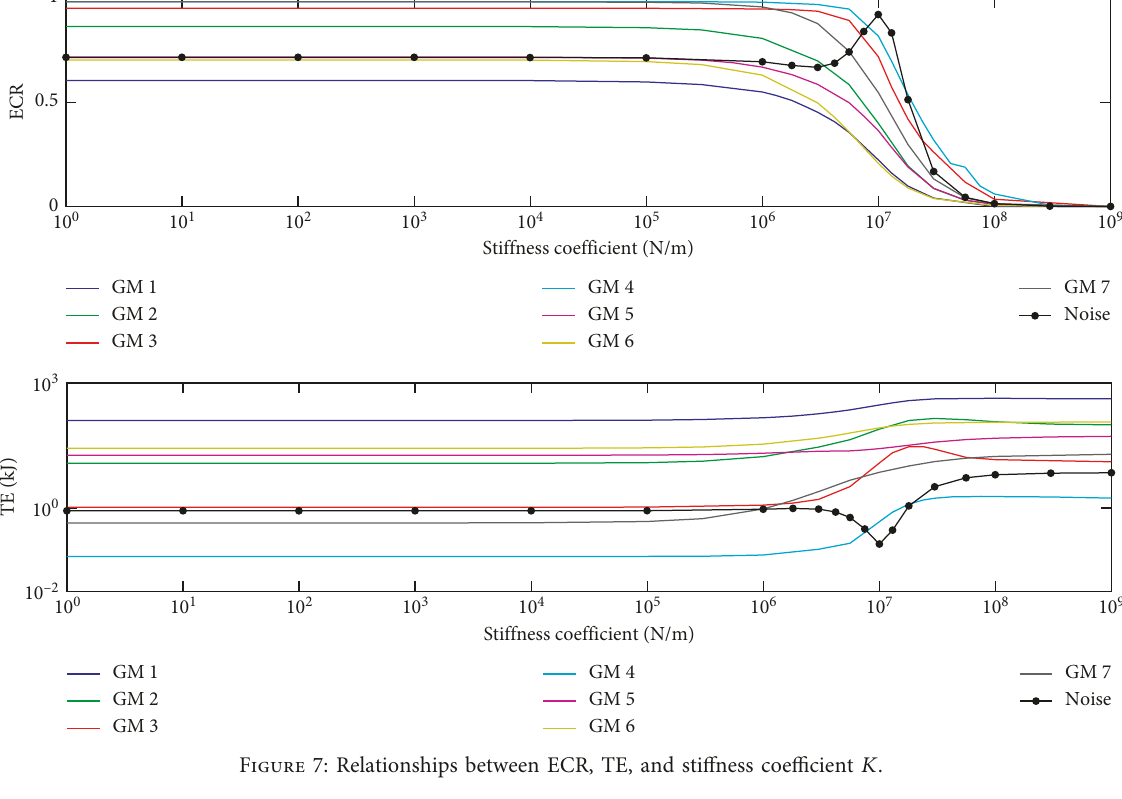
Figure 7: Relationships between ECR, TE, and stiffness coefficient K